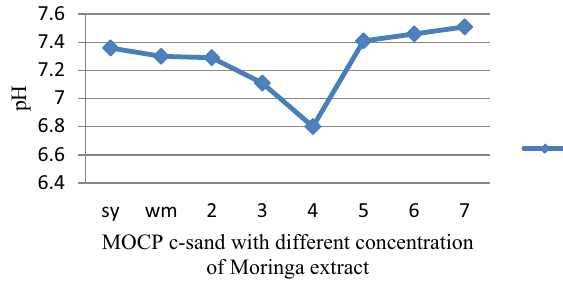
Fig. 3 Observed pH during column